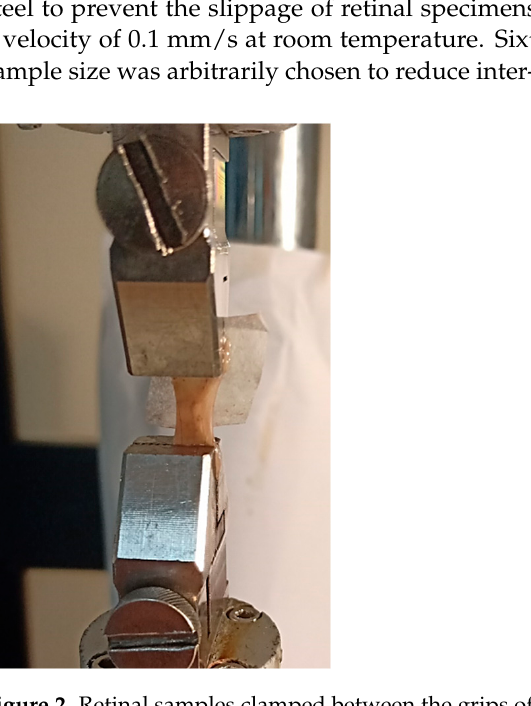
Figure 2. Retinal samples clamped between the grips of the testing machine .